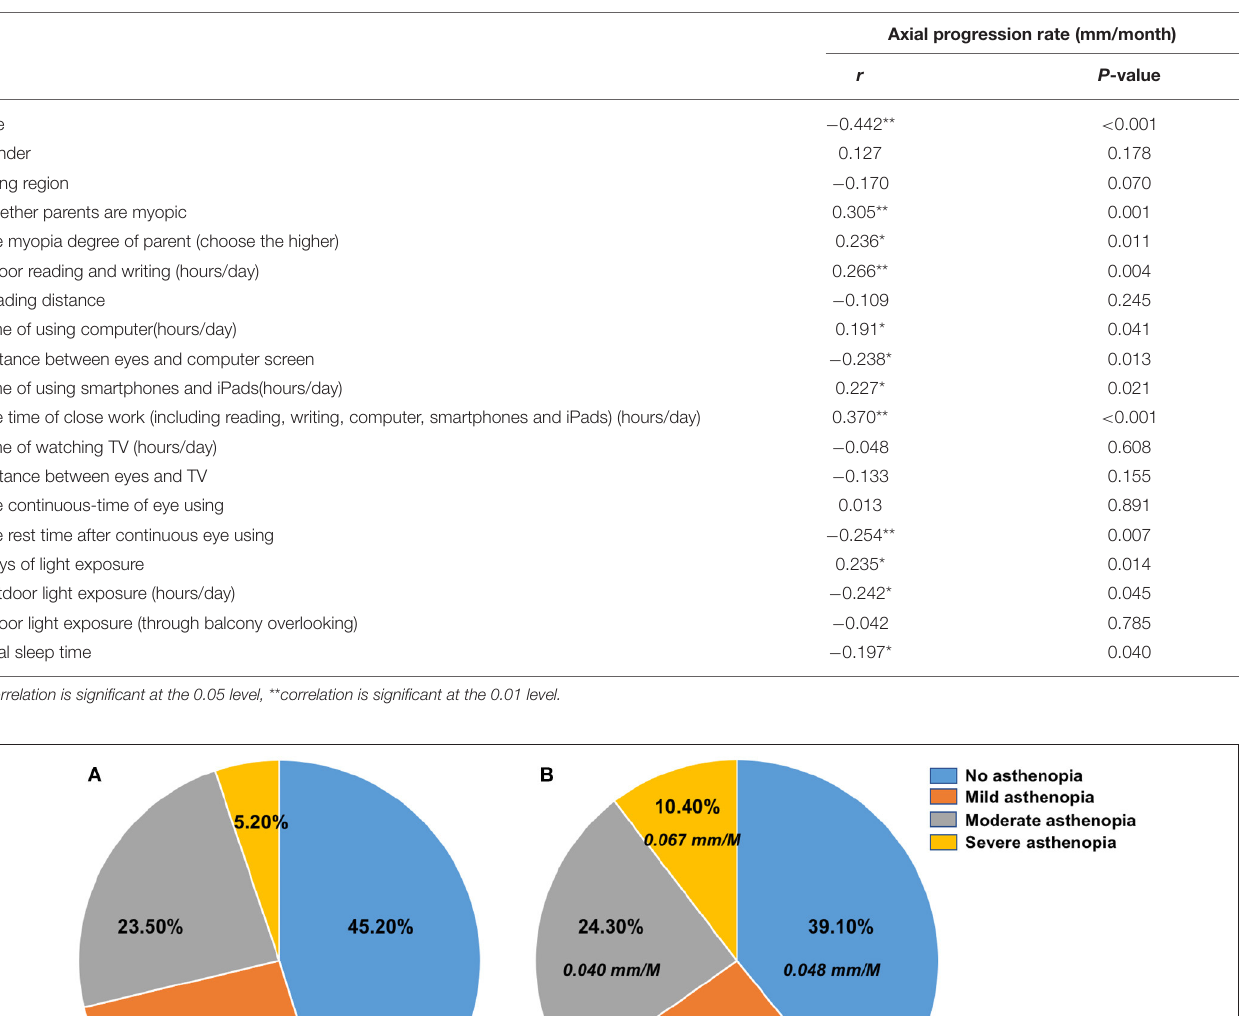
TABLE 2 | Correlation analysis of eye care habits on the growth rate of eye axial length.